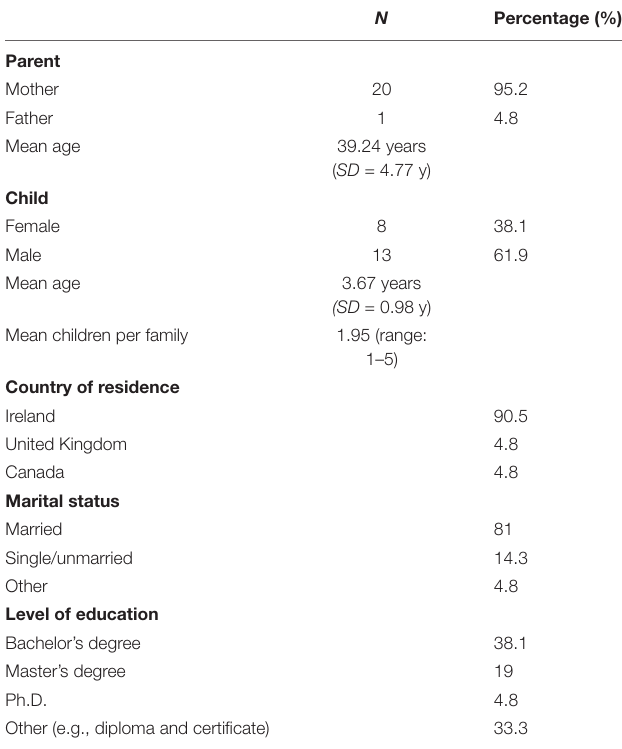
TABLE 1 | Demographic information for participating parents and